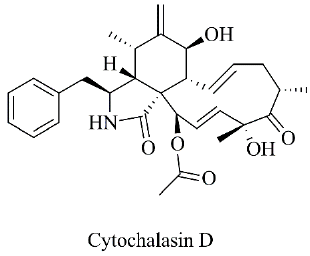
Figure 16. Chemical structure of cytochalasin D.